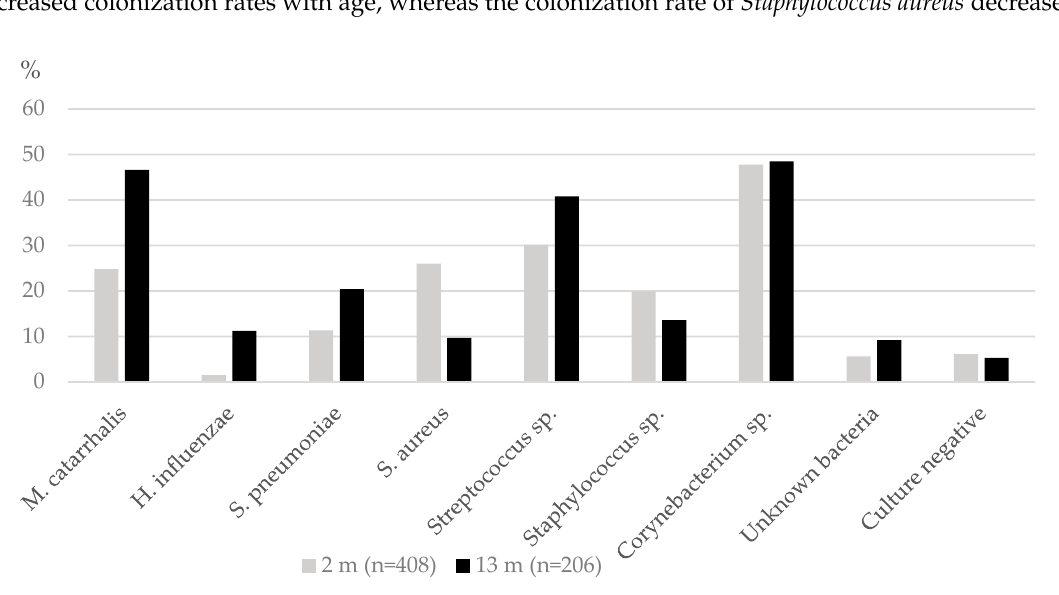
Figure 2. The colonization rates of the studied bacteria at two time points. Table 2. Association between TLR4 gene polymorphism Asp299Gly (rs4986790) and nasopharyngeal bacterial colonization rates at 2 months and 13 months of age.